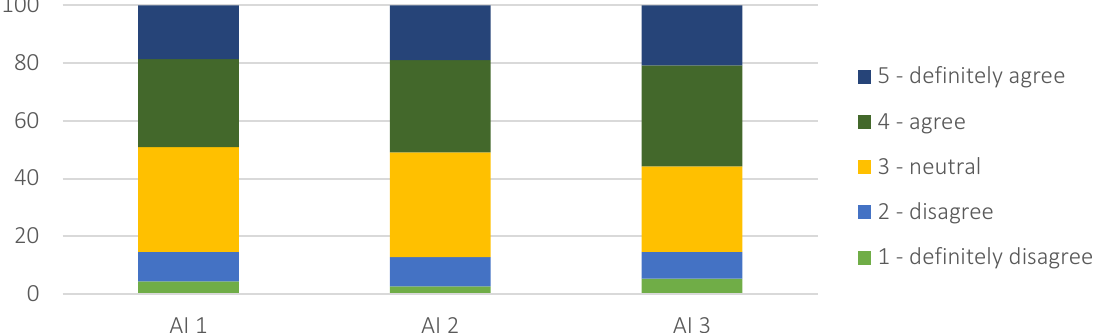
Figure 3. Availability of information factor